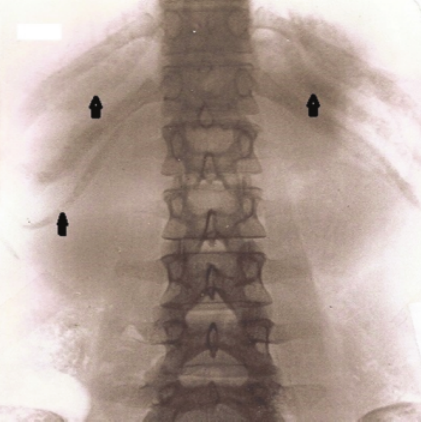
Figure 1: Almost complete calcification of the costal cartilages in a 20-year-old woman. See